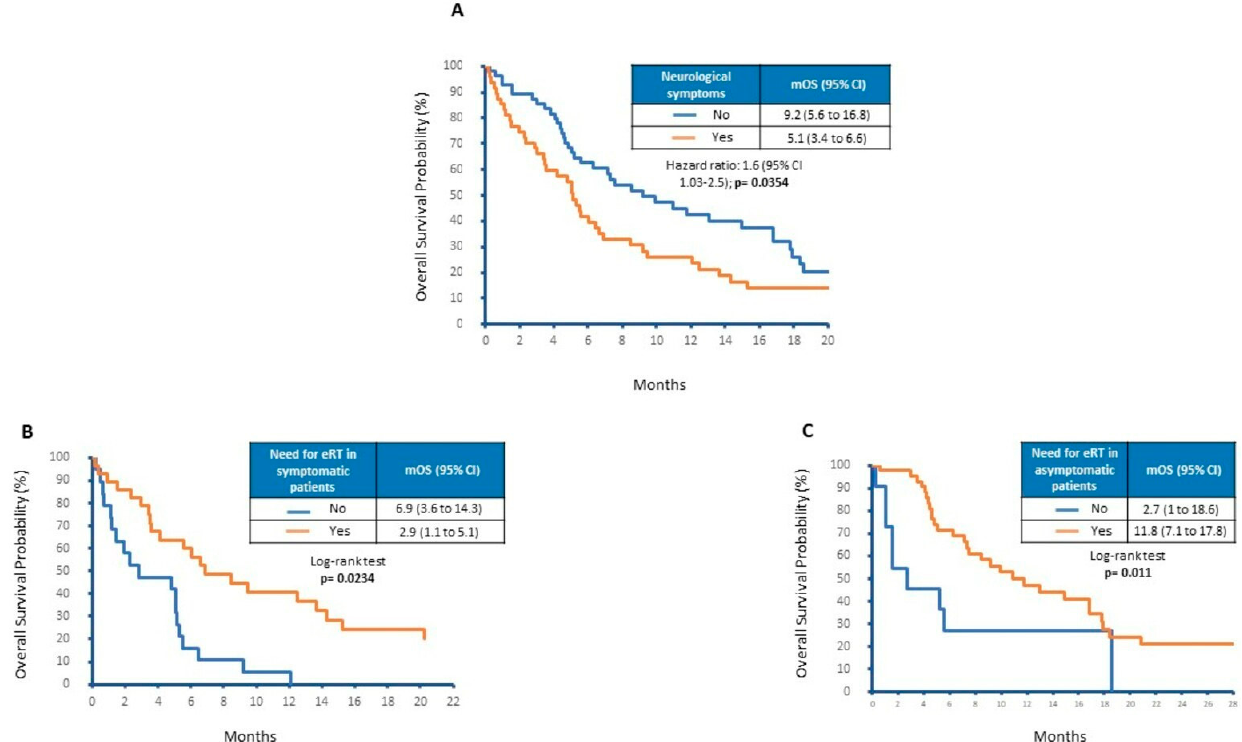
Figure 1. Overall survival according to ( A ) neurological symptoms, ( B ) eRT in symptomatic patients and ( C ) eRT in asymptomatic patients .